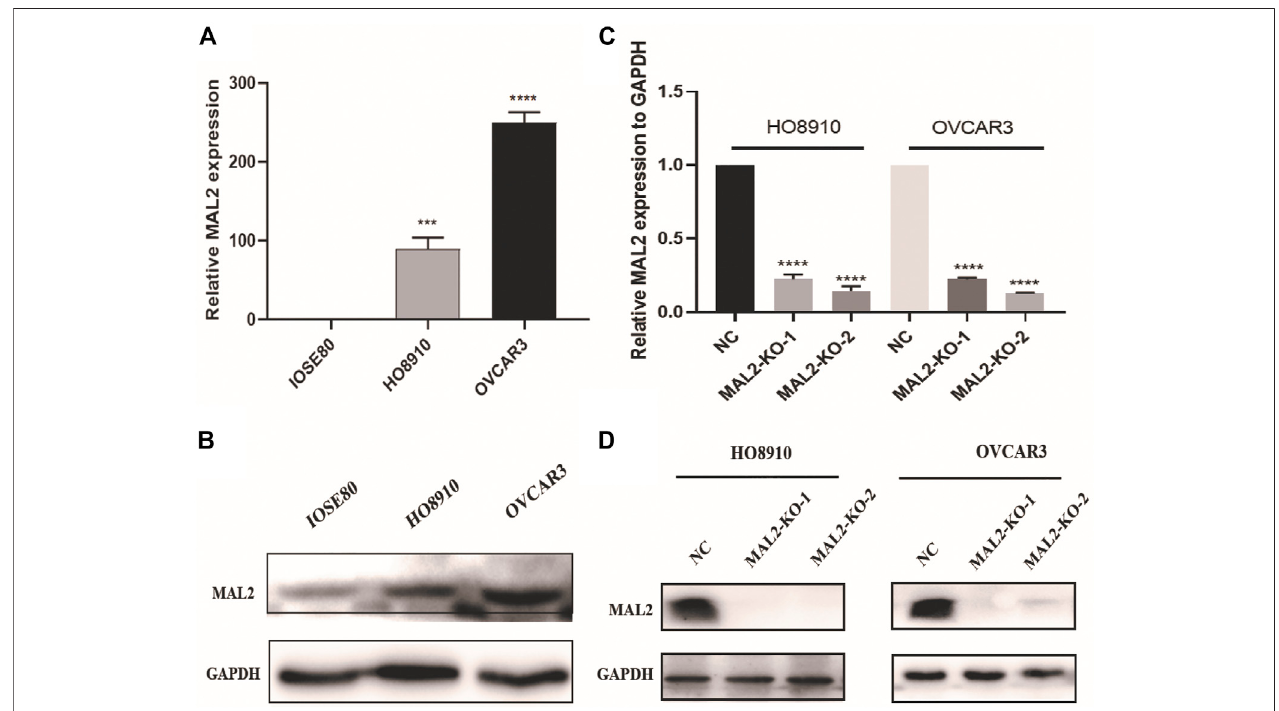
FIGURE 6 | The expression of MAL2 in OC cell lines. (A) and (C) The expression status of MAL2 was analyzed by real-time quantitative polymerase chain reaction (qRT-PCR). * p < 0.05; ** p < 0.01. (B) and (D) The relative expression of MAL2 (compared with that of GAPDH) was examined via western blotting.